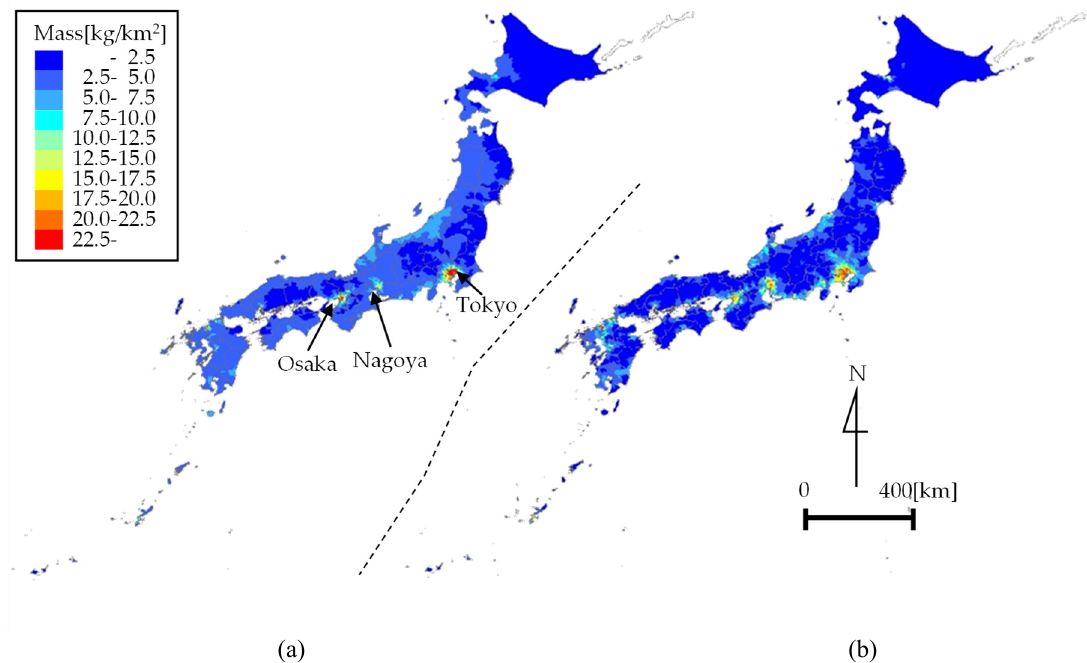
Figure 9. Total plastic emissions over 1 km grids in Japan. The MicP mass concentrations were evaluated via linear approximation for population density ( a ) and urban area ratio ( b ) with the same ratio of MacP/MicP = 3.13. Warmer colors indicate higher emissions, while cooler colors indicate lower emissions.